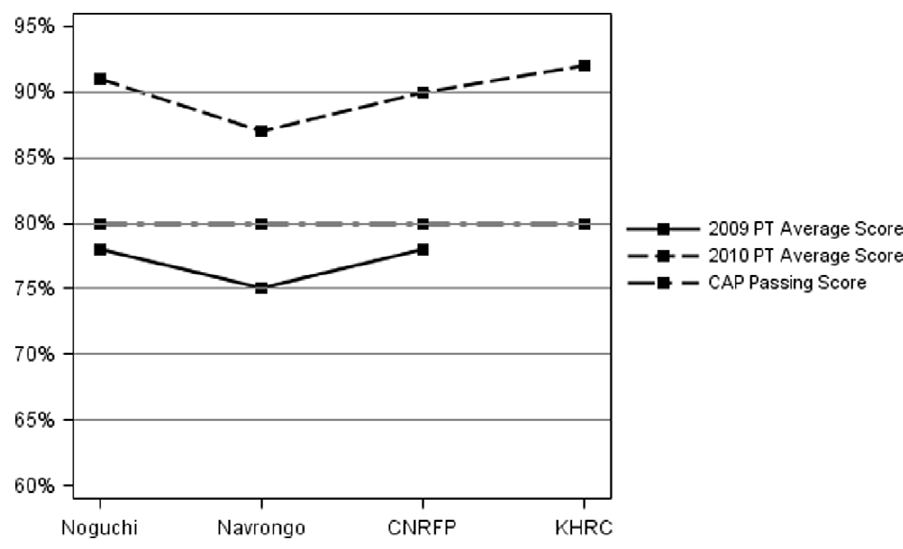
Figure 2. Average PT performance by site.